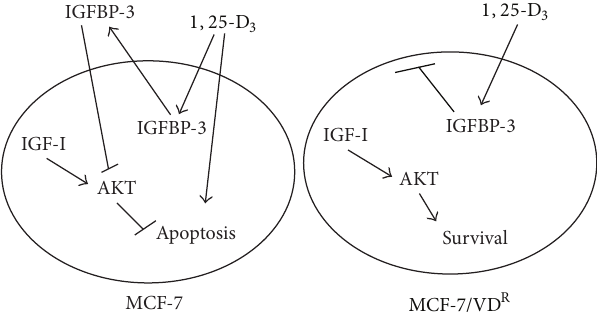
Figure 5: Proposed interaction between 1, 25-D 3 and IGFBP-3 in MCF-7 and MCF-7/VD R cells. In parental cells stimulation by 1, 25-D 3 ofIGFBP-3secretionattenuatesIGF-1-inducedactivationof Akt, leading to apoptosis. In addition, 1, 25-D 3 may initiate caspase- independent pathways contributing to cell death in parental cells. In resistant cells, failure of IGFBP-3 secretion is associated with activation of the IGF-I/Akt pathway, leading to cell